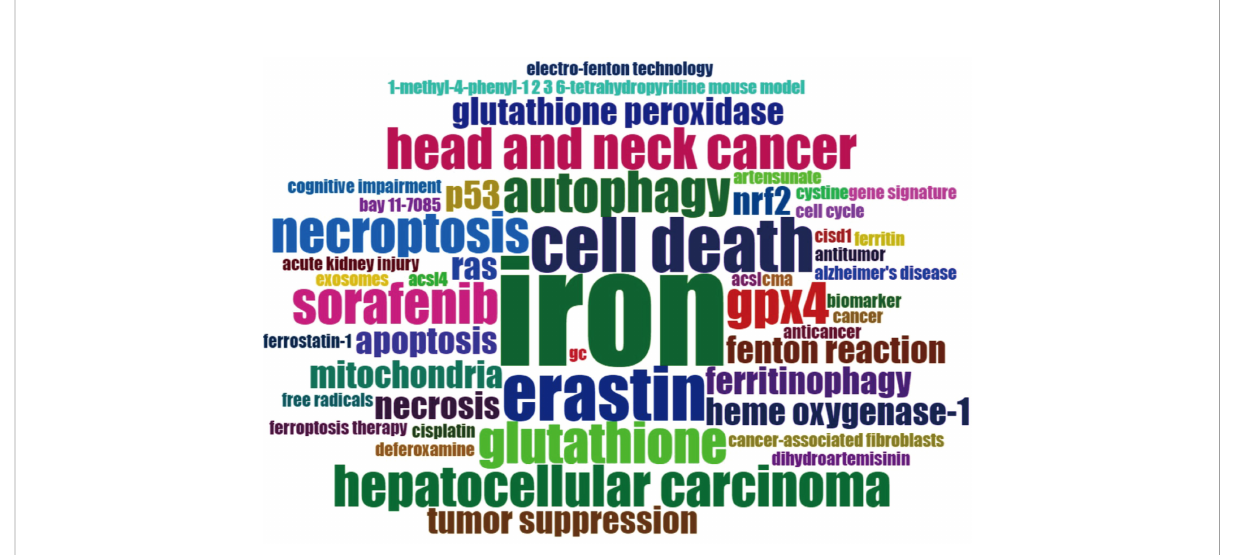
FIGURE 8 Cloud map of author keywords. Note: the keyword of “ ferroptosis ” was not included in this